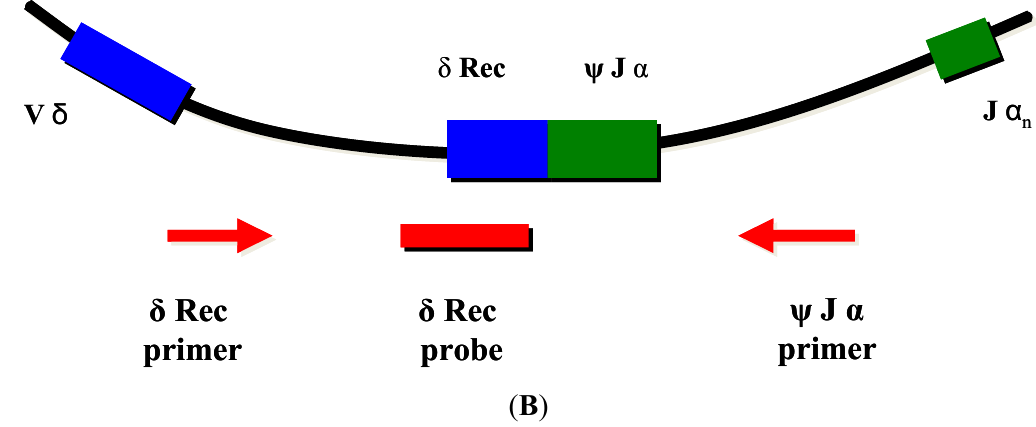
Figure 2. T-cell receptor excision circles (TREC) assay principle. PCR detection strategy for the probe-based detection of the signal joint of T cell receptor excision circles (sjTREC). Before formation of TRECs in T cell precursors ( A ), the primer and probe design will not lead to detectable amplification, as the signal joint is only found when circular end-joining is completed ( B ). The ~100 bp sjTREC amplicon is amplified using sequence-specific oligonucleotide primer and hydrolysis probes in a typical real-time qPCR